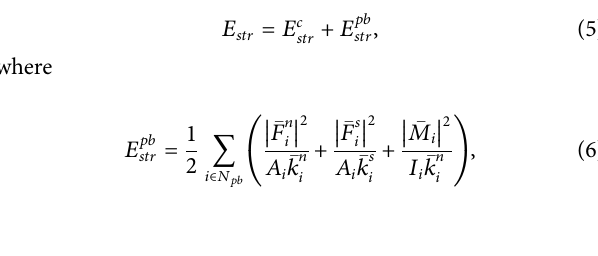
Frontiers in Earth Science |